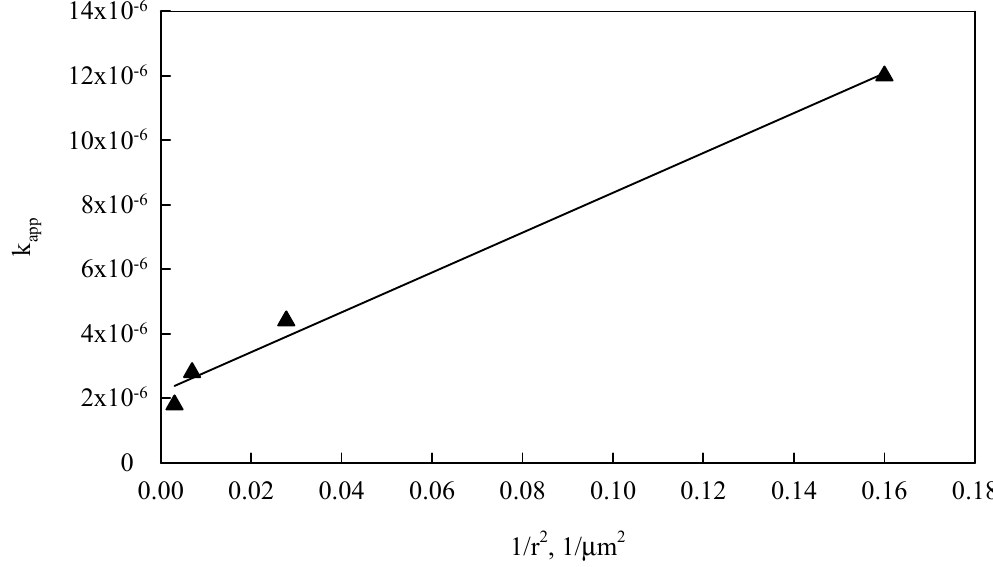
Figure 16. Evaluation of the inverse of the average particle size.